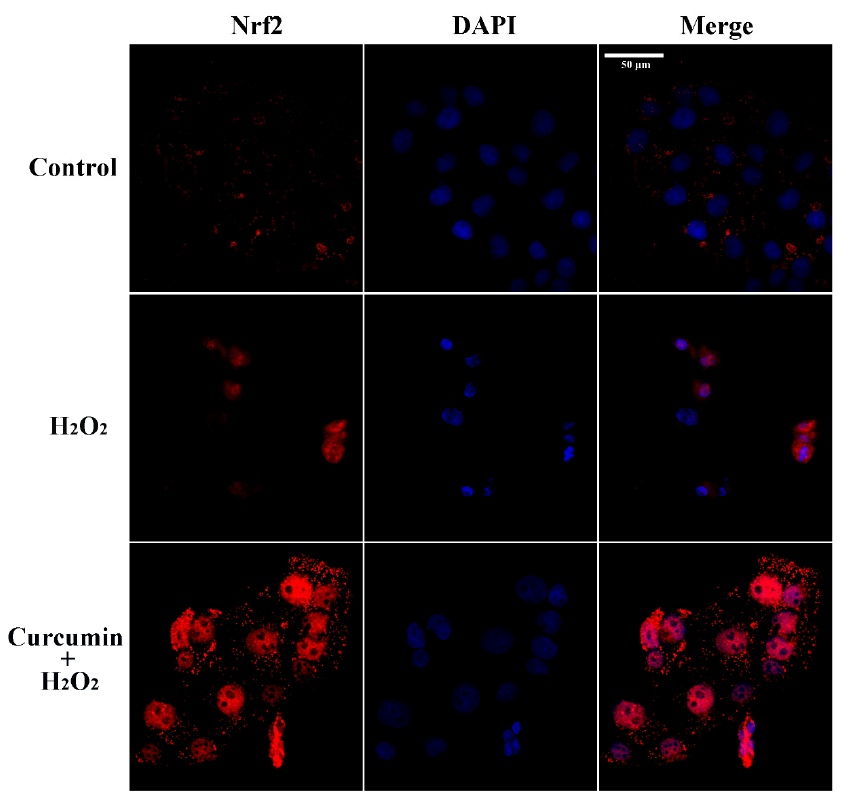
Figure 6. E ff ects of curcumin on Nrf2 nuclear translocation in HTR8 / SVneo cells. Immunofluorescence staining of Nrf2 in HTR8 / SVneo cells treated with H 2 O 2 or pre-treated with 5 µ M curcumin for 24 h and Figure 6. Effects of curcumin on Nrf2 nuclear translocation in HTR8/SVneo cells. Immunofluorescence staining of Nrf2 in HTR8/SVneo cells treated with H 2 O 2 or pre-treated with 5 H 2 O 2 for another 24 h. Blue and red colors indicate localization of DAPI (nuclei) and Nrf2, respectively. μ M curcumin for 24 h and H 2 O 2 for another 24 h. Blue and red colors indicate localization of DAPI Scale bar = 50 µ (nuclei) and Nrf2, respectively. Scale bar = 50 μ m.